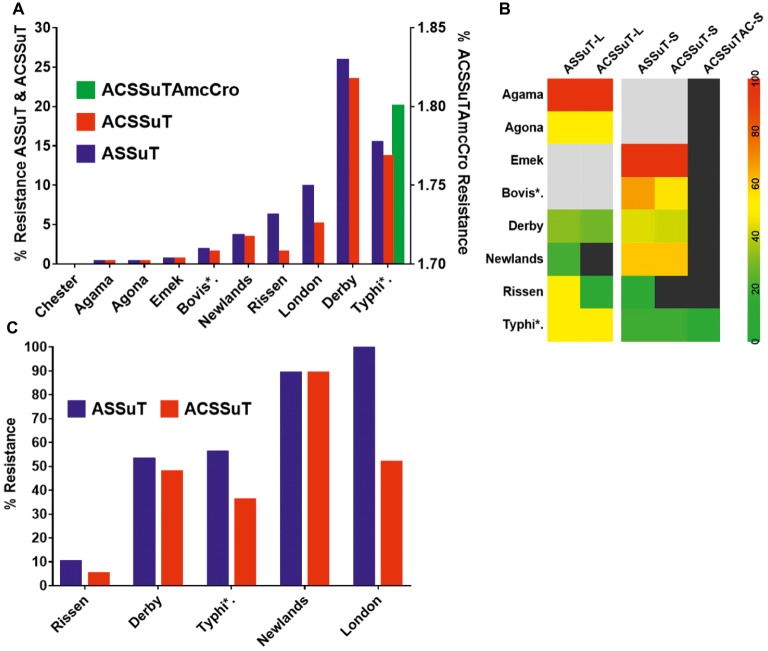
The multiple-drug resistance (MDR) patterns of Salmonella serovars. (A) MDR patterns for individual serovars isolated in this study. The left X-axis shows tetra- and penta-resistance while the right X-axis shows hepta-resistance pattern (seen only in serovar Typhimurium). (B) MDR pattern (in percent) according to the farm type. Gray boxes indicate the absence of serovars whereas black boxes represent the absence of resistance. L- indicates large farms, SMS- indicates small- and medium-scale farms. (C) MDR pattern in the isolates from the slaughterhouse. The pattern is abbreviated as resistance to A, Ampicillin; C, chloramphenicol; S, streptomycin; Su, sulfamethoxazole; T, tetracycline; Amc, amoxicillin, and Cro, ceftriaxone. Abbreviated names of the serovars are Bovis*: Bovismorbificans and Typhi*: Typhimurium.